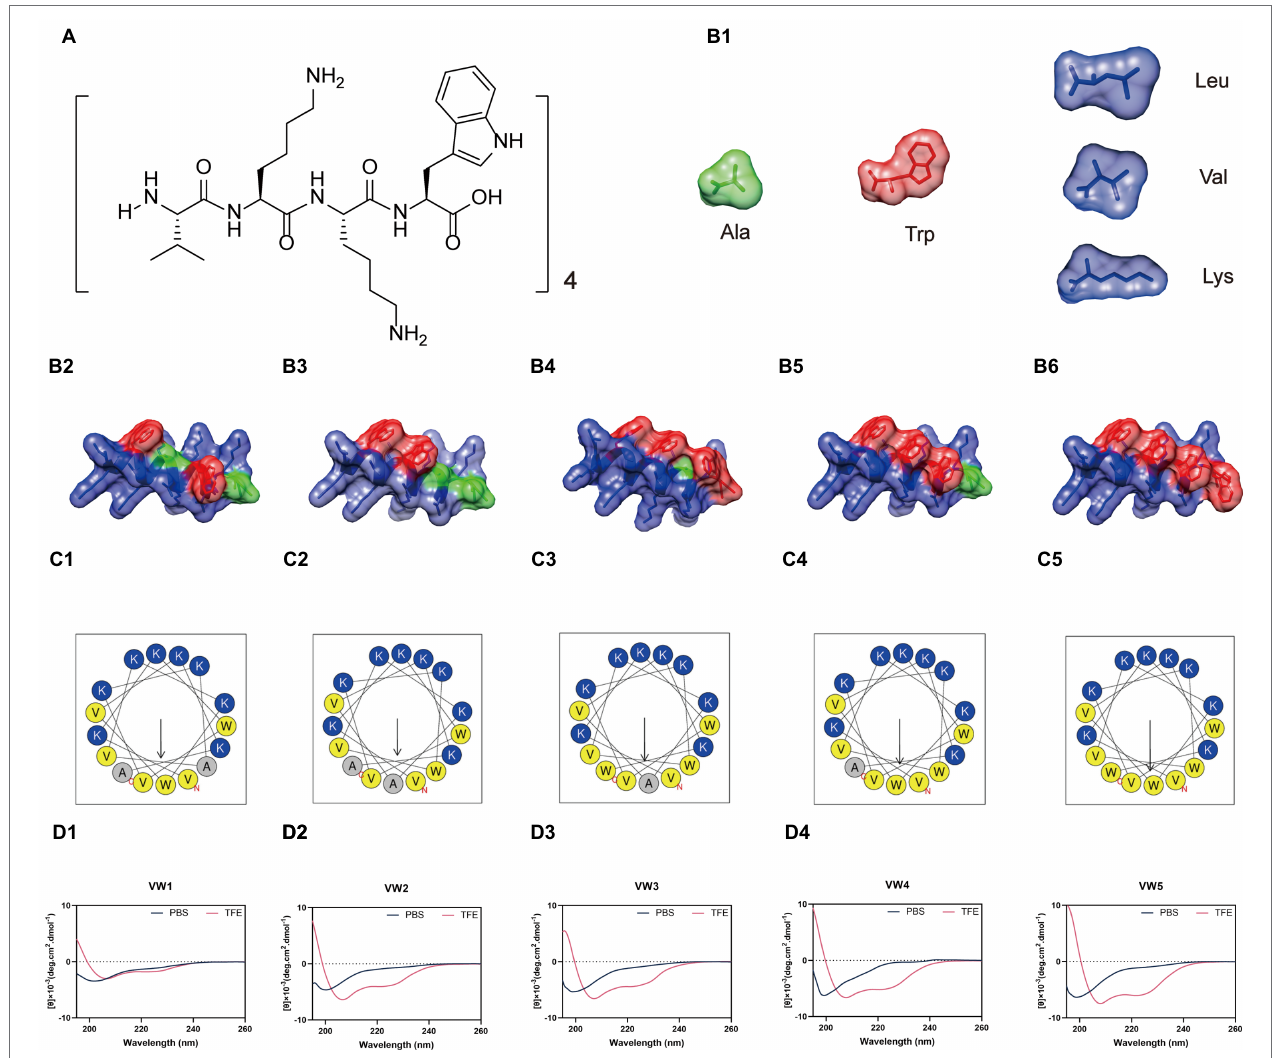
FIGURE 1 | (A) Schematic structure of peptides based on the template (VKKX) 4 , where X represents W, A, or L. (B) The backbone structure and potential surface of peptides. The green structure represents Ala residues, the red structure is Trp residues, and the blue structure represents other amino acid residues involved in the sequence. (C) The helical wheel projections of peptides. The charged amino acid residues are colored as dark blue and the hydrophobic amino acid residues are painted as dark yellow. (D) The circular dichroism (CD) spectrum of